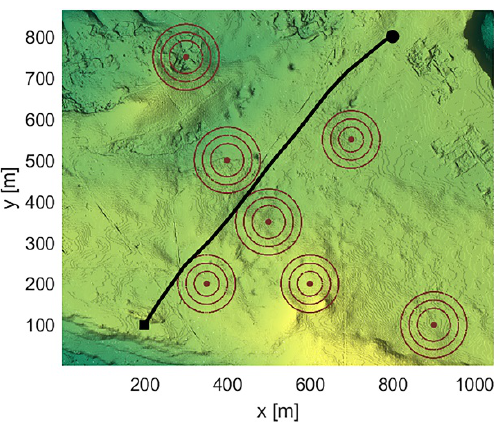
Figure 6. Top view of the path generated by the IC-VAINDIWPSO algorithm.